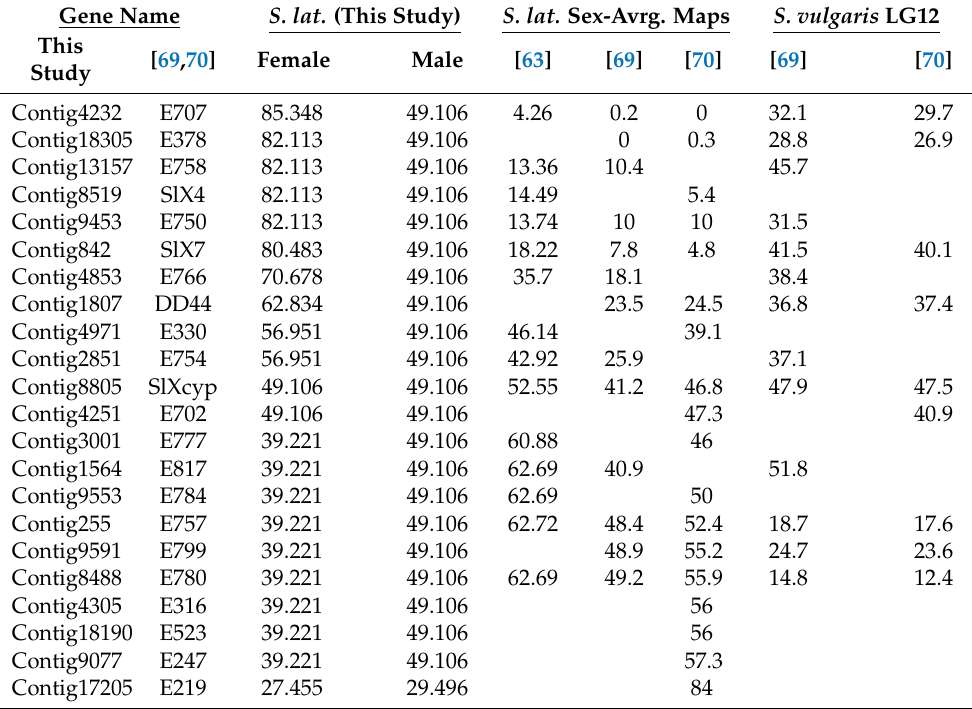
Figure 3. A comparison of different genetic maps for the S. latifolia X-chromosome. Names of the genes are shown along the horizontal axis. The vertical axis shows a rescaled fraction of the total map length for each gene. The genetic positions for S. latifolia genes listed in Table 2 were rescaled and re-oriented for maps to have the same orientation and length. The male map is not shown because it lacks recombination [62,69,70]. Table 2. Genetic positions of S. latifolia X-linked genes and their S. vulgaris homologs.